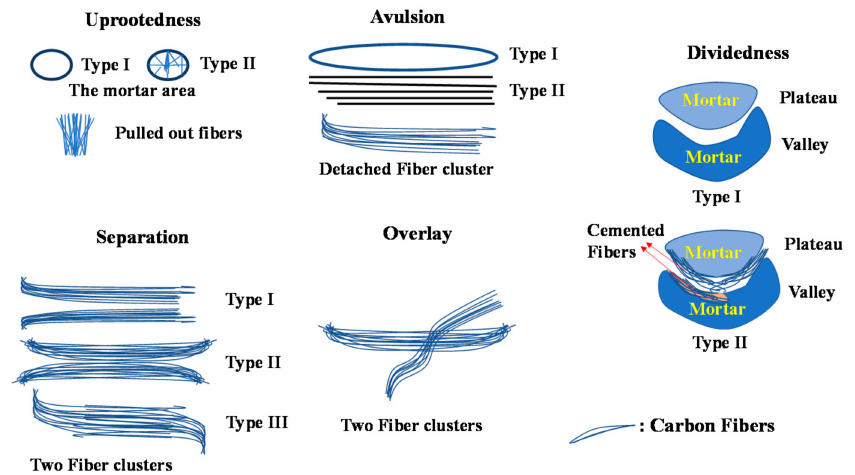
Figure 4. Fiber traces found from the cracked surfaces of prisms. The avulsion, separation and overlay are caused by fiber